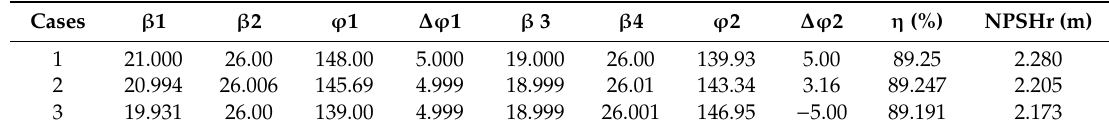
Figure 15. Pareto-frontiers from ANN. Table 6. Variables for Optimum Cases.